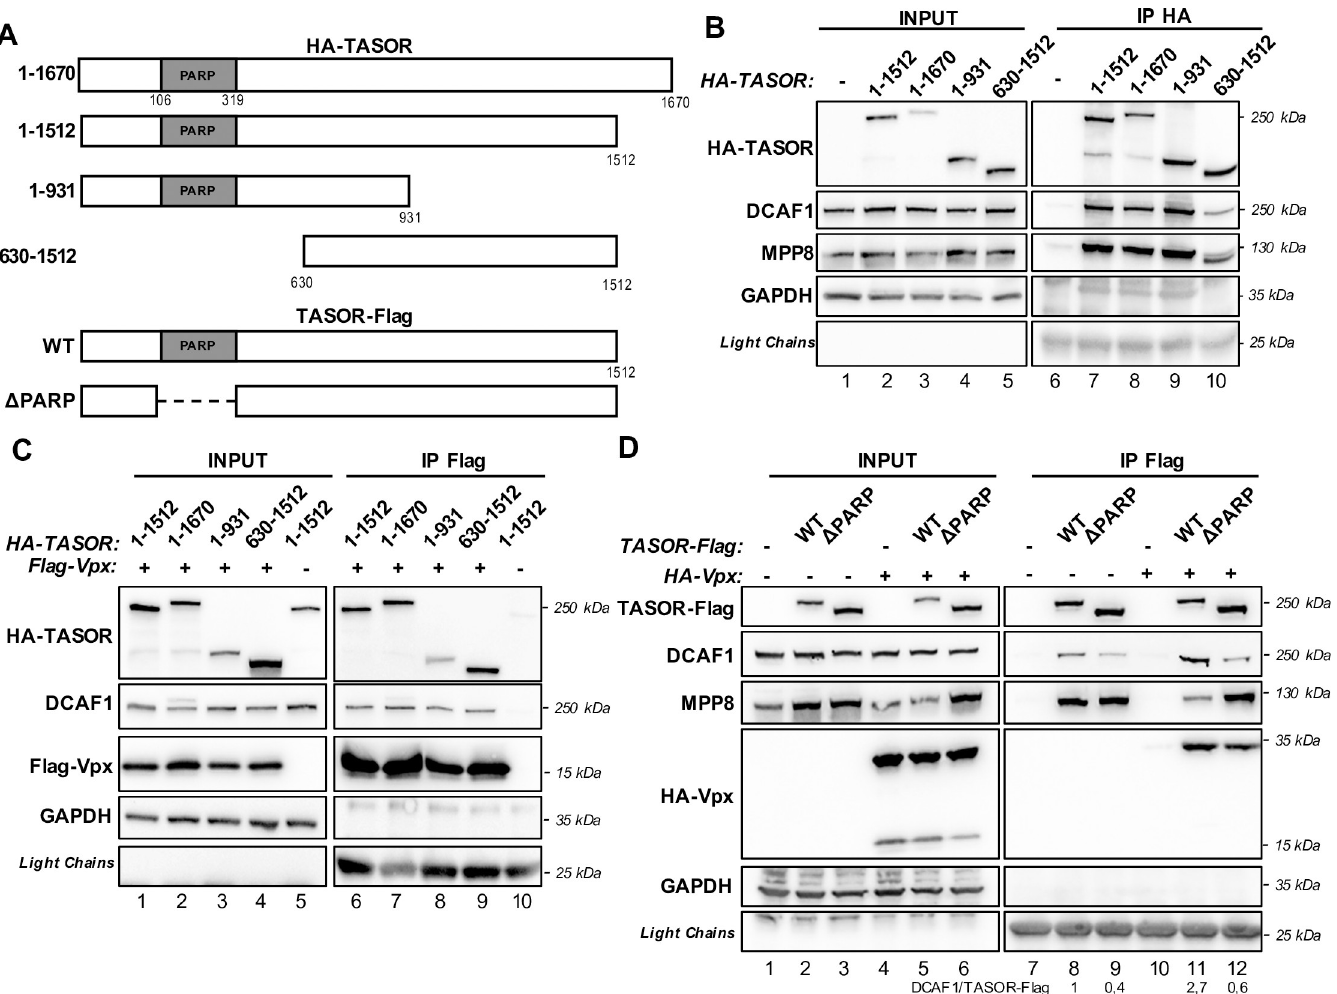
Fig 2. TASOR PARP- like domain is involved in DCAF1 binding. ( A ) Schematic representation of HA-tagged TASOR or Flag-tagged TASOR constructs. 1–1670 : TASOR long isoform. 1–1512 : TASOR short isoform. 1–931 : N-terminal fragment of TASOR. 630–1512 : C-terminal fragment of TASOR short isoform. WT : TASOR (short isoform). Δ PARP : TASOR (short isoform) deleted of its PARP- like domain (106–319 aa). ( B ) Indicated HA-TASOR constructions were expressed in HeLa cells, then an anti-HA immunoprecipitation was performed. ( C ) Flag-Vpx WT and indicated HA-TASOR constructs were co-expressed in HeLa cells, then an anti-Flag immunoprecipitation was performed. ( D ) TASOR-Flag WT or TASOR- Δ PARP-Flag were co-expressed with HA-Vpx WT in HeLa cells, then an anti-Flag immunoprecipitation was performed. In each panel, the indicated proteins were revealed by western blot. For this figure, each shown immunoblot is representative of at least 3 independent